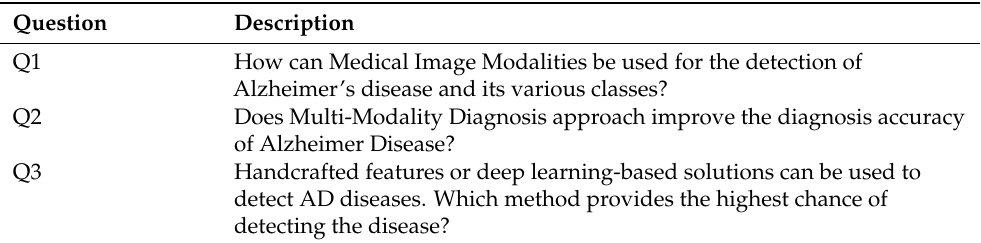
Table 1. Research Question based on